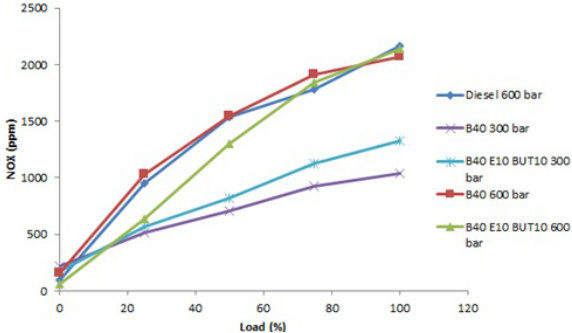
Fig. 5. Various Oxides of Nitrogen with Engine